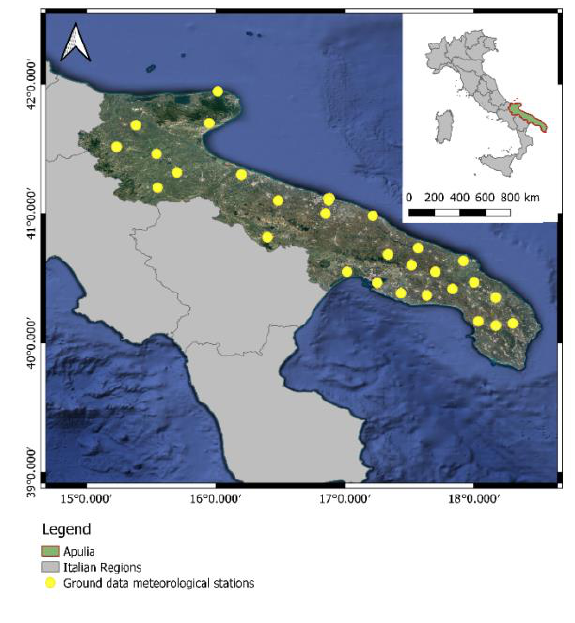
Fig. 4: Study area– Puglia Region (Italy)